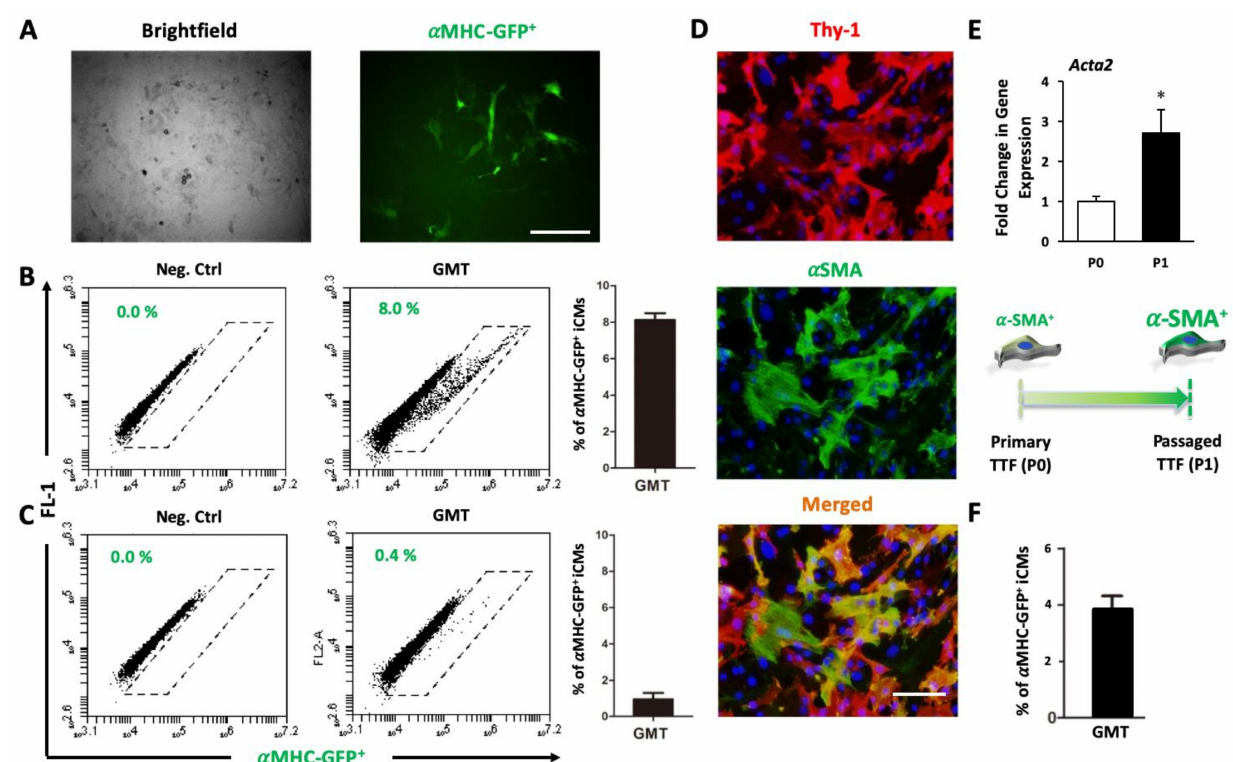
Figure 1. The plasticity of in vitro cultured fibroblasts varies. ( A ) Brightfield (left) and GFP (right) representative im- ages of induced cardiomyocyte (iCM) reprogramming (Day 8) from tail-tip fibroblasts (TTFs). Bars indicate 50 µ m. ( B – C ) Representative FACS plots and average percentage of α MHC-GFP + iCMs reprogrammed from TTFs with relatively good ( B ) and low ( C ) efficiency. ( D ) Immunostaining of TTFs for fibroblast marker Thy1 (in red) and myofibroblast marker α SMA (in green), showing that cultured fibroblasts were differentiated into myofibroblasts. Bars indicate 200 µ m. ( E ) qRT-PCR shows that gene expression of Acta2 , a myofibroblast marker, was significantly higher in single-passaged cells TTFs (P1) than that in primary TTFs (P0), indicating myofibroblast differentiation in cultured fibroblasts. ( F ) Average percentage of α MHC-GFP + iCMs reprogrammed from passaged TTFs. * p < 0.05 vs. P0